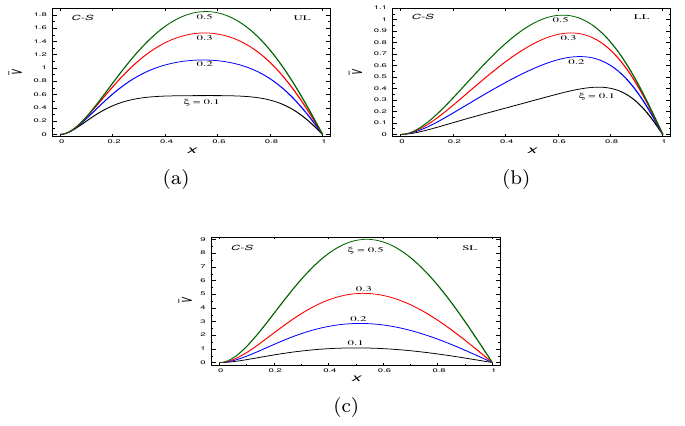
Figure 4. Effect of nonlocal parameter ξ on the distribution of angular displacement along the axial direction of a C-S CNT subjected to: (a) UL, (b) LL, and (c) SL.